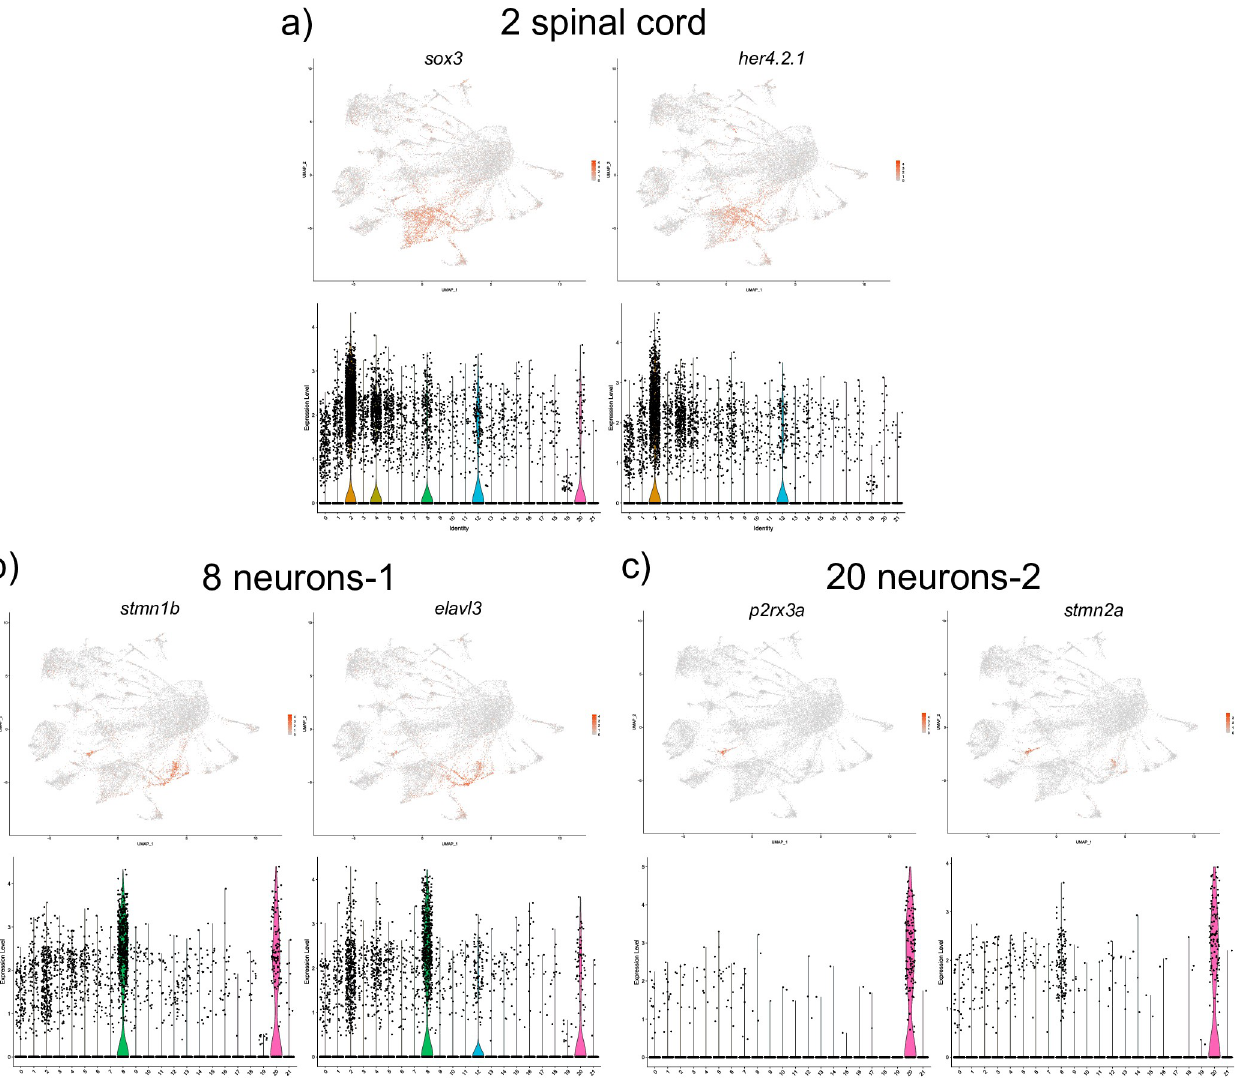
Fig 4. UMAP and violin plots showing the expression of selected marker genes for spinal cord (cluster #2, a), neurons-1 (cluster #8, b) and neurons-2 (cluster #20, c).